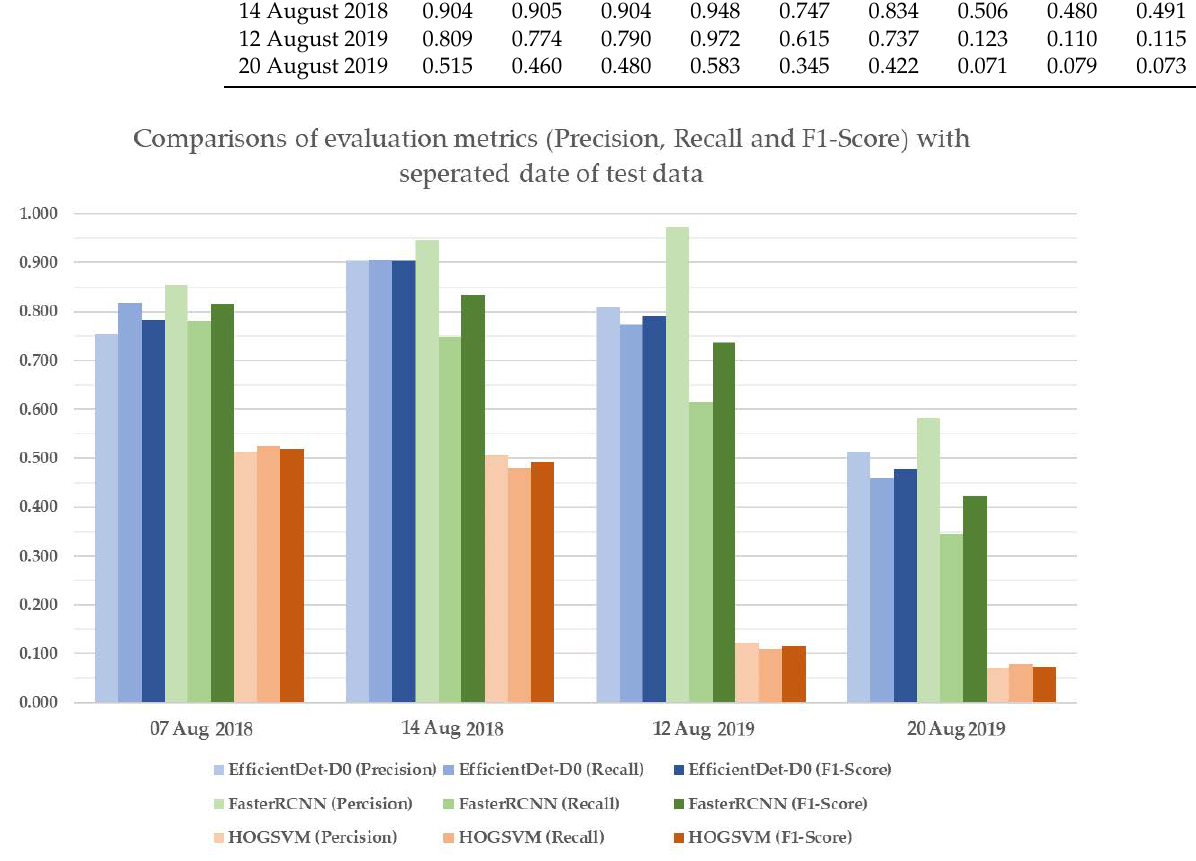
Figure 16. Comparison of evaluation metrics (precision, recall and F1-score) on four